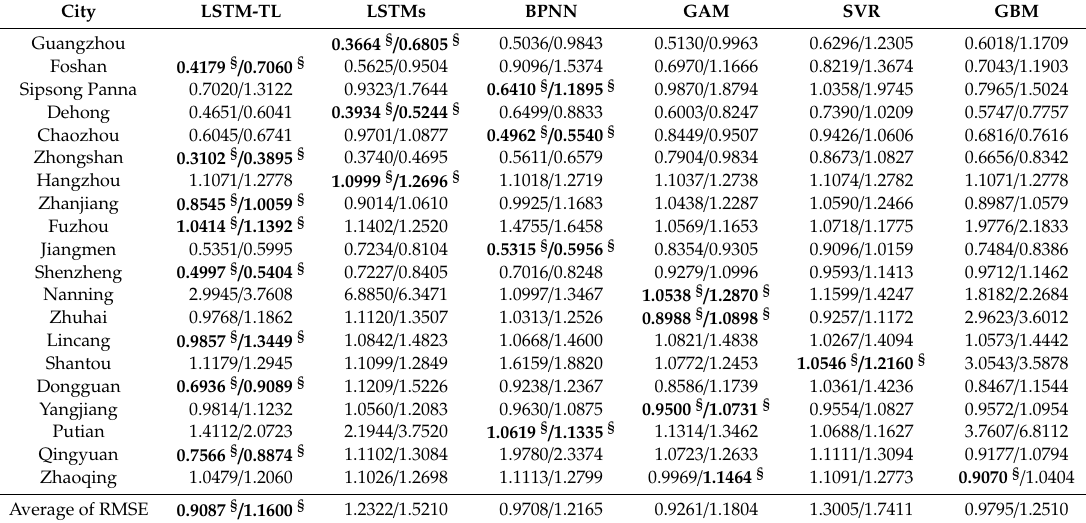
Table 4. Comparison of the models’ goodness-of-fit using the root relative squared error (RRSE). The number before the symbol “ / ” is the RRSE of the model prediction for the last 24 months, and the number after the symbol “ / ” is the RRSE of the model prediction in the outbreak period (July to November in 2017 and 2018).